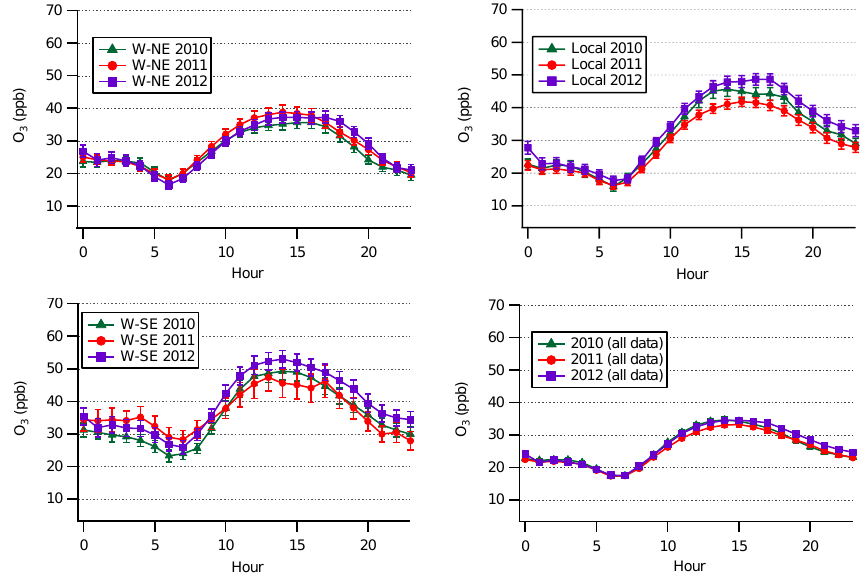
Figure 5. O 3 hourly summer averages at Downtown2 Toronto station (error bars represent standard deviation of the mean).